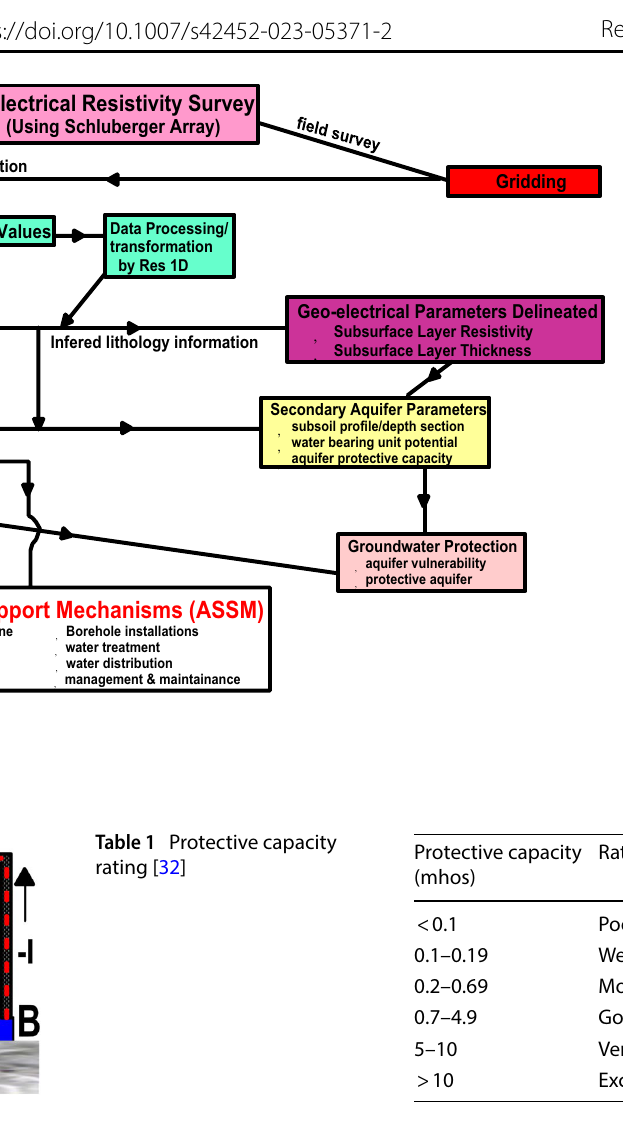
Fig. 3 Schlumberger